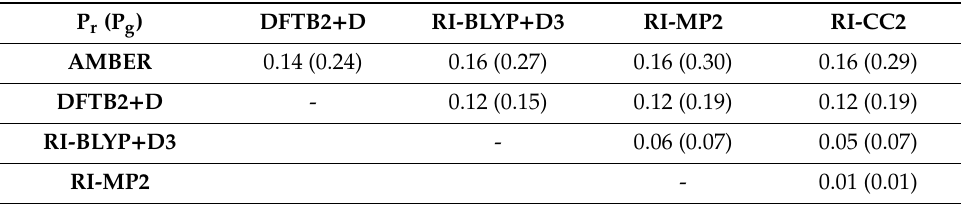
Table 3. Root mean square deviations of geometries in Å. Comparisons are given for methods in the corresponding column and row for P r (first value) and P g (second value, shown in parenthesis). For alignment, the geometries were reduced to 42 atoms as in case of the optimizations in vacuo. They were obtained from QM / AMBER optimized structures with QM66, while AMBER denotes pure force field